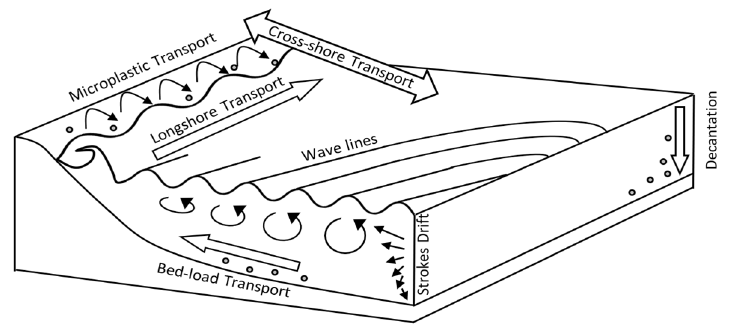
Figure 7. Schematic diagram of longshore microplastic diffusion mechanisms (modified from Critchell and Lambrechts, 2016) [127].